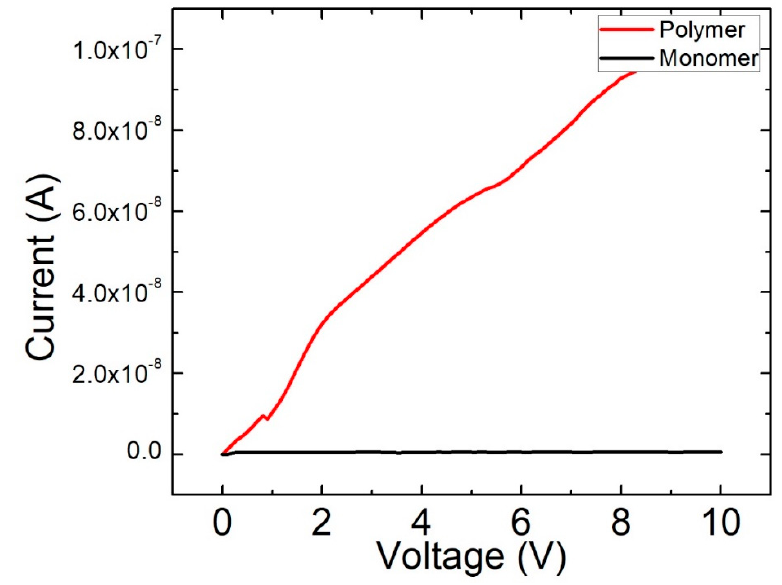
Figure 5. Conductivity of poly(o-aminophenol) film after plasma treatment.